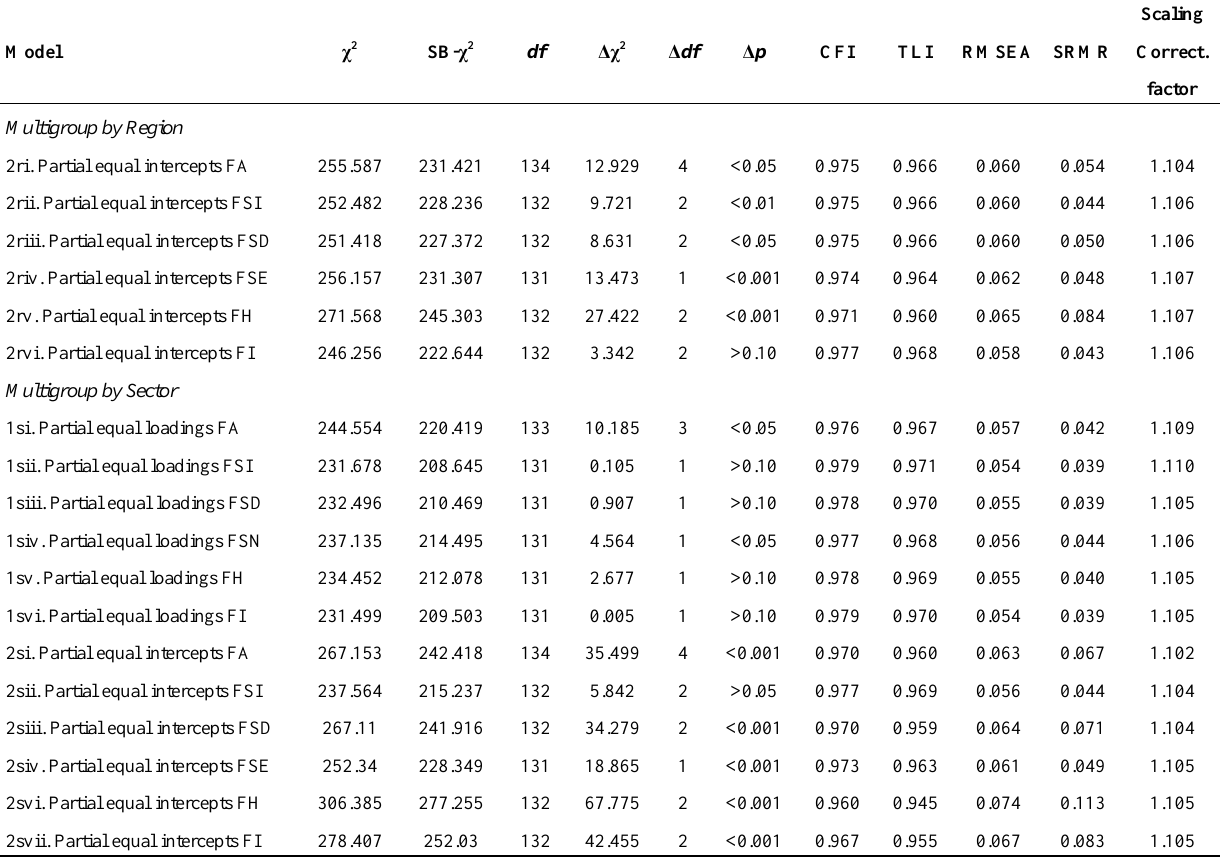
Table 6. Domestic teleconferencing: partial measurement and structural invariance tests. Model